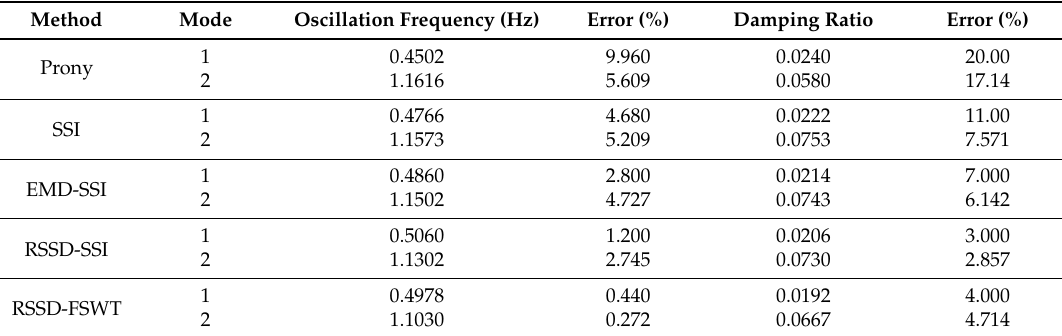
Table 4. Result of identification with Gaussian noise ( σ =